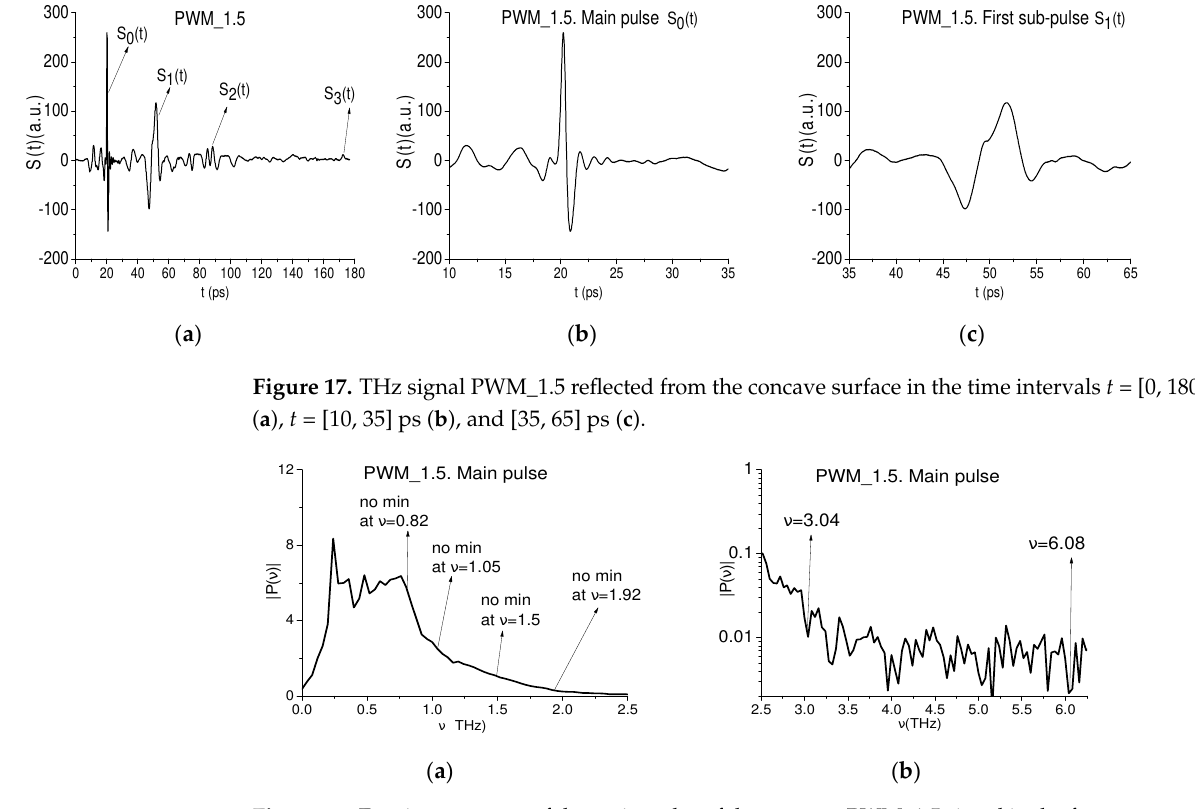
frequency ν = 1.16 THz are absent in Figure 18a. This is a consequence of the influence of the inhomogeneous surface on the spectrum of the THz pulse reflected by this surface. At the same time, in Figure 18b, one can see two spectral minima at the frequencies ν = 3.04, the case of the rough surface, we denote this THz signal as the PWM_1.5 signal, and it is 6.08 THz, which are close to the RDX absorption frequency ν = 3.0 THz and its doubled shown in Figure 17a. The magnified view of the main pulse and the first sub-pulse is pre- frequency ν = 6.0 THz. Let us recall that in Section 4.1, we showed the absence of water ( ) S t Figure 17c also sented in Figure 17b,c. As mentioned above, the first sub-pulse 1 vapor absorption frequencies in the range ν = [0.1, 2.5] THz belonging to the reference Figure 17. THz signal PWM_1.5 reflected from the concave surface in the time intervals t = [0, 180] ( ) S t Figure demonstrates the inversion of the phase in comparison with the main pulse spectrum. Thus, the spectral minimum at the frequency ν = 6.08 THz may be caused by the ps ( a ), t = [10, 35] ps ( b ), and [35, 65] ps ( c ). 0 absorption frequency doubling in the PWM_1.5 main pulse. 17b. The reference signal is the same as for the PWM_40 THz signal.